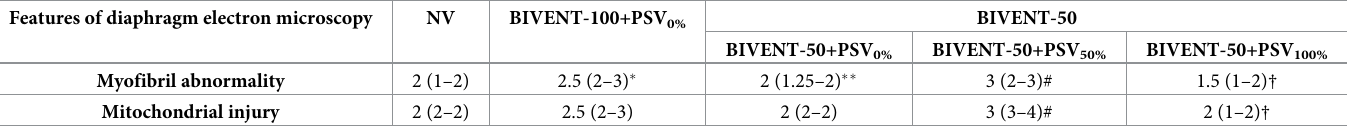
Table 4. Semiquantitative analysis of diaphragm electron